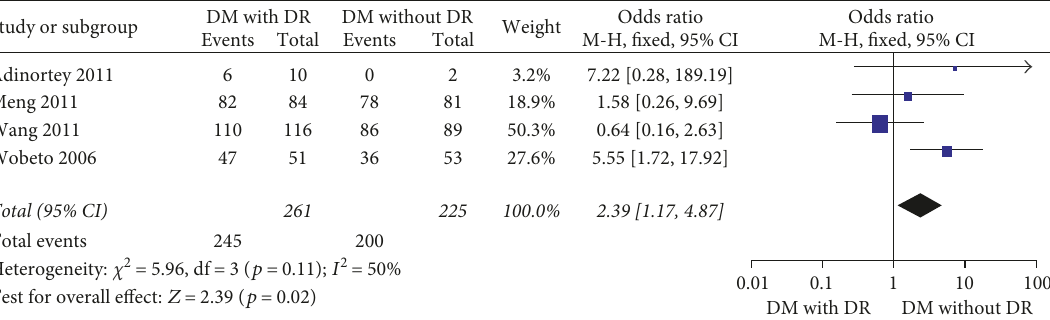
Figure 5: Forest plot for meta analysis comparing DR with DWR in heterozygote model (TC versus CC).